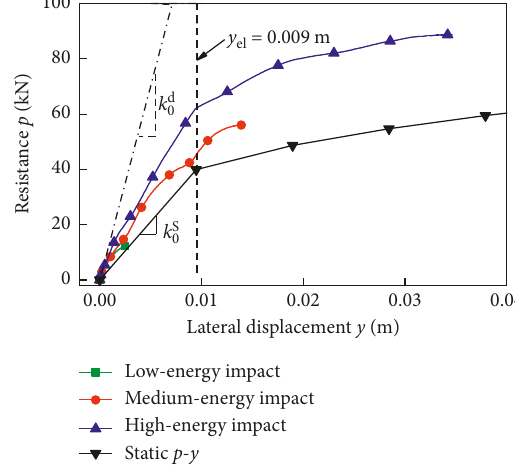
Figure 8: Pile lateral displacement in the 5 th row. Figure 9: Soil p-y curves of the 1 st